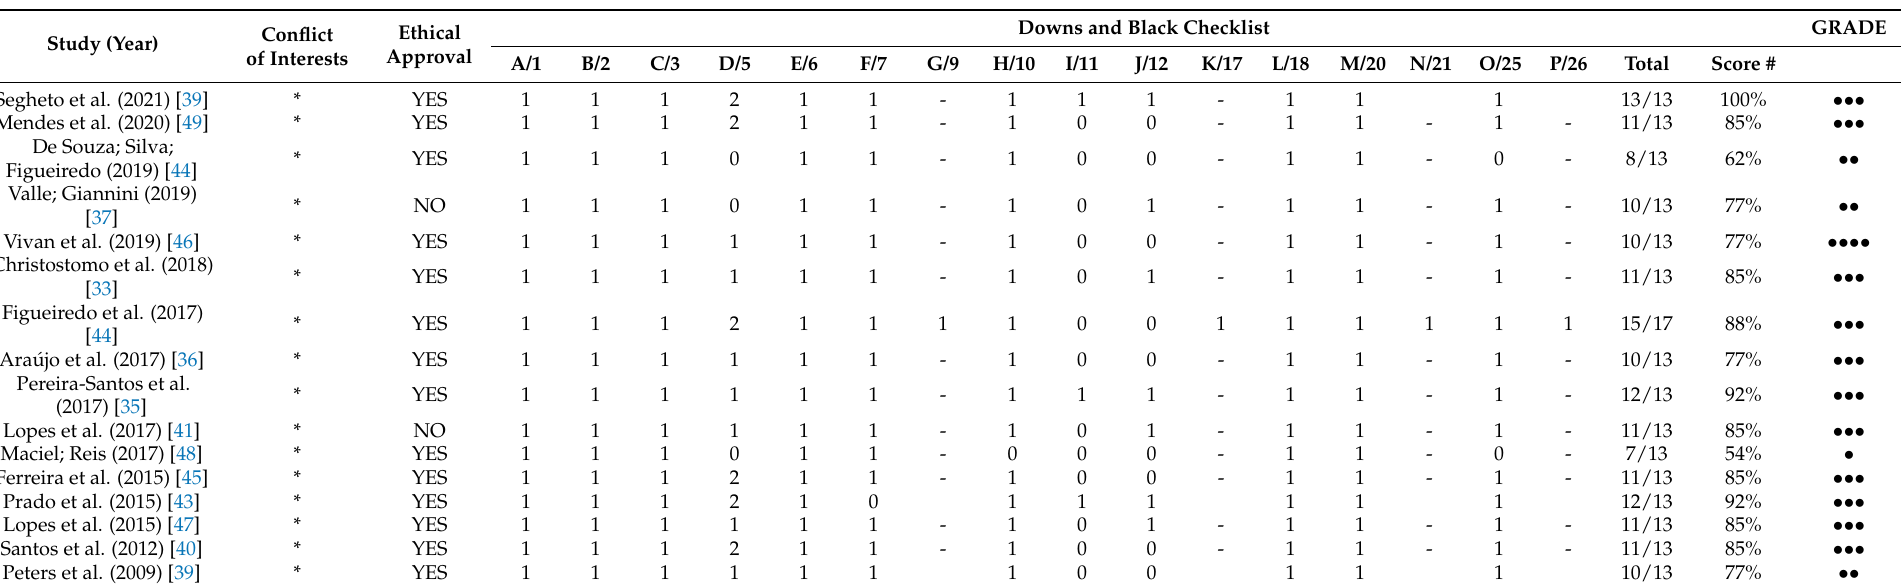
Table 2. Score of studies according to quality criteria by Downs and Black and Grade